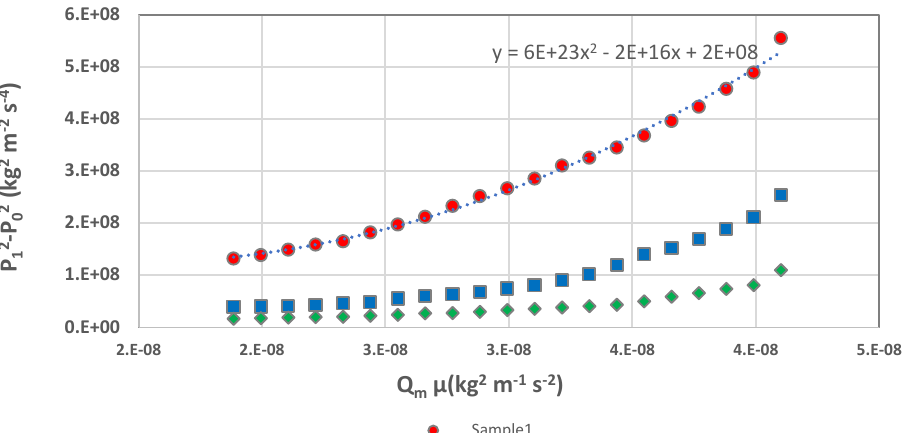
Figure 3. Nonlinearity of Darcy flow check of the samples 1, 2, and 3. During the flow of air through the samples, a pressure loss occurs, which results in a decrease in the volumetric flow rate, but the mass flow rate remains constant. These changes in pressure and volumetric flow lead to a change in air properties such as density and viscosity.